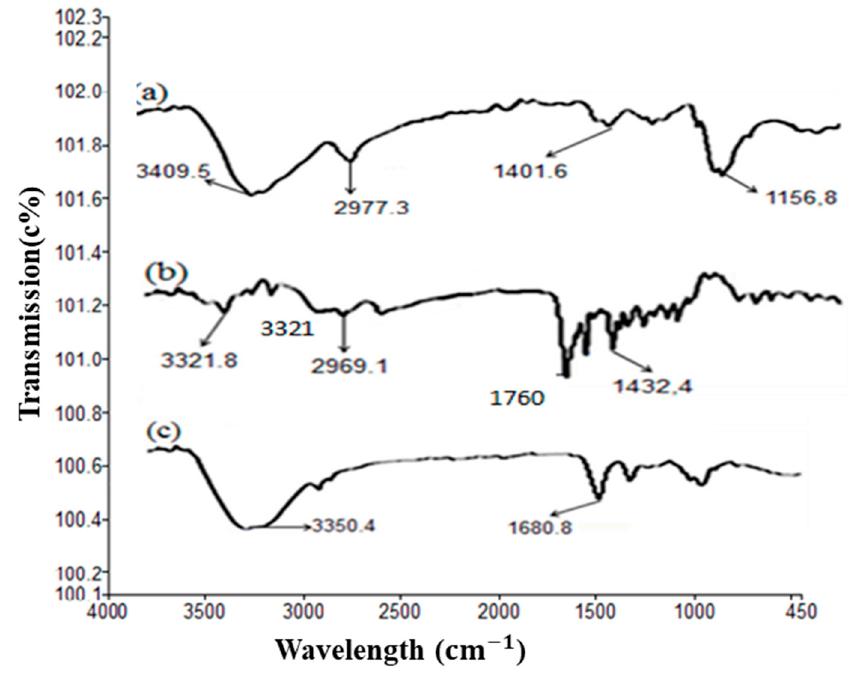
Figure 2. FT-IR illustration of the conjugation of FA with chitosan: (a) pure chitosan, (b) pure FA, and (c) FA-CS conjugate.